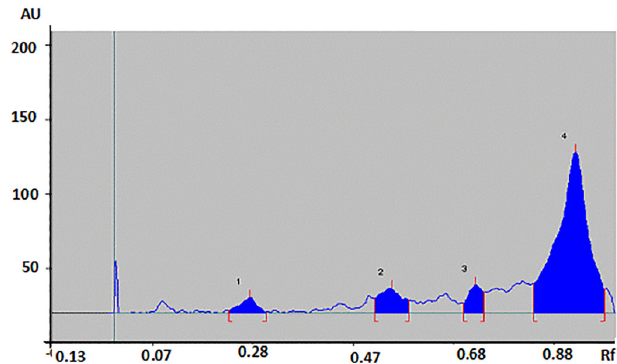
FIGURE 1 - HPTLC fingerprint of alcohol extract of W. volubilis root at 425